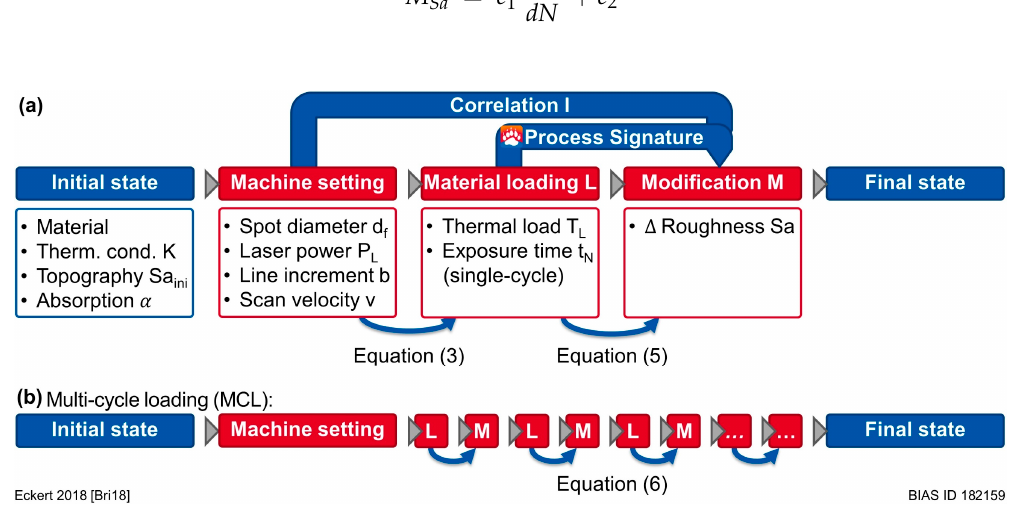
Figure 10. Schematic illustration of Process Signatures in accordance to [28], ( a ) applied on the laser-induced electrochemical polishing process, and ( b ) the concept of a multiple, recurring loading of the same constant amount of energy within one process (multi-cycle load).